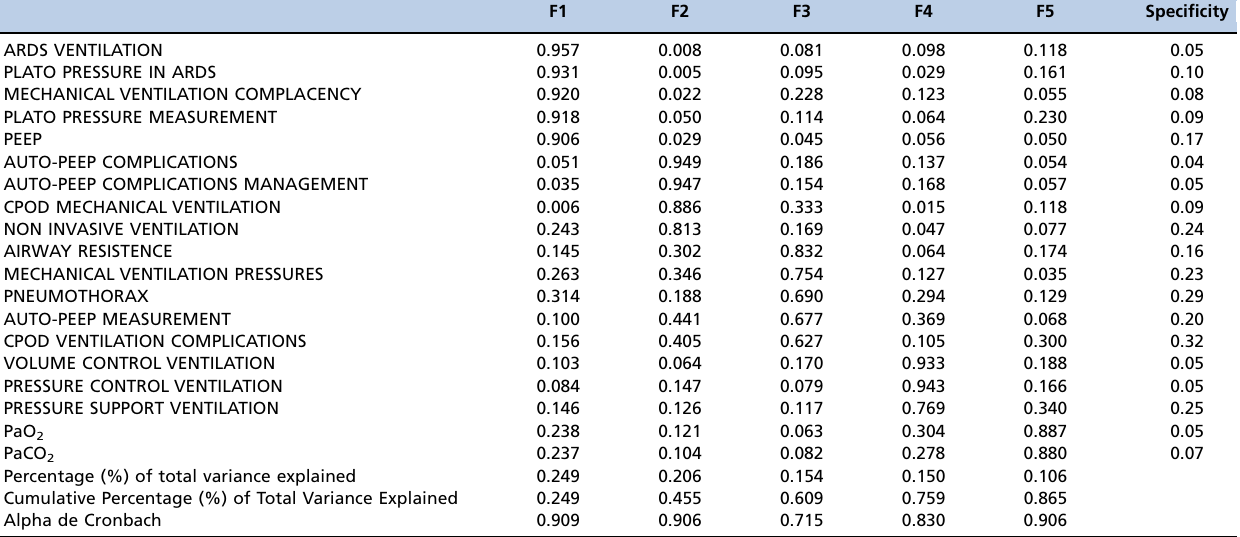
Table 3 - Factor Matrix.